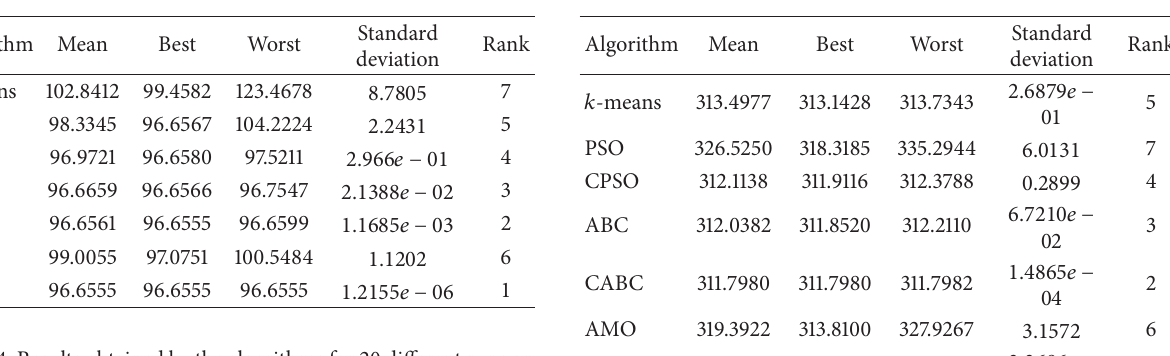
Table 3: Results obtained by the algorithms for 20 different runs on Iris data.